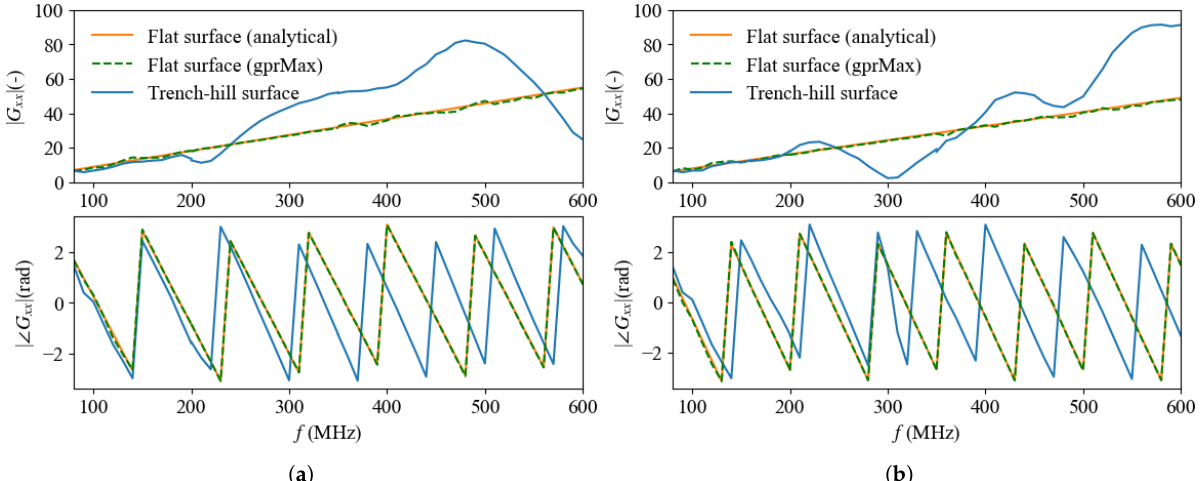
Figure 4. Simulated trench-hill and flat surface Green’s functions by gprMax, and analytical Green’s function for the flat surface in the frequency domain. ( a ) The source/receiver was situated above the central hill of the trench-hill surface. For the relevant flat surface Green’s function (the green dash line), the distance between the source/receiver and the surface h was 1.78 m. ( b ) The source/receiver was situated above the trench of the trench-hill surface, and the corresponding flat surface was with h defined as 2